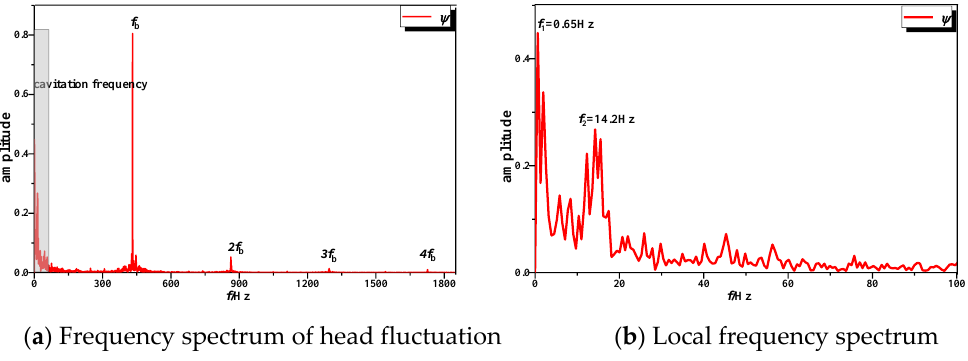
Figure 19. Frequency domain distribution of impeller.